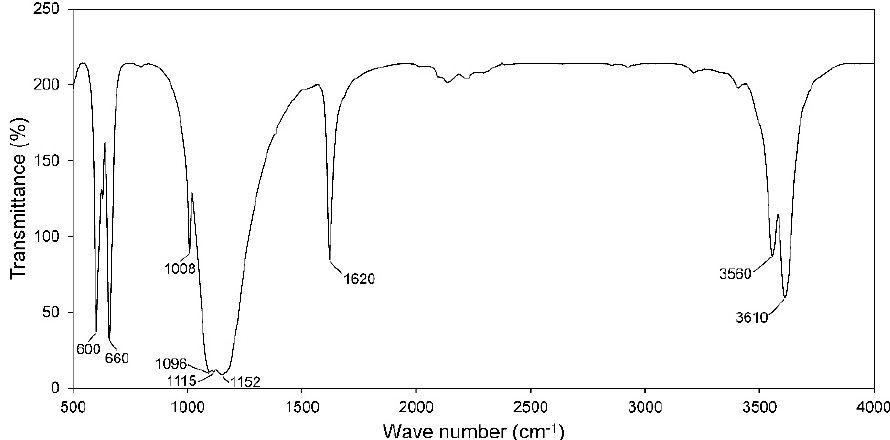
Figure 1. Fourier transform infrared (FTIR) spectroscopy of the synthesized powder.